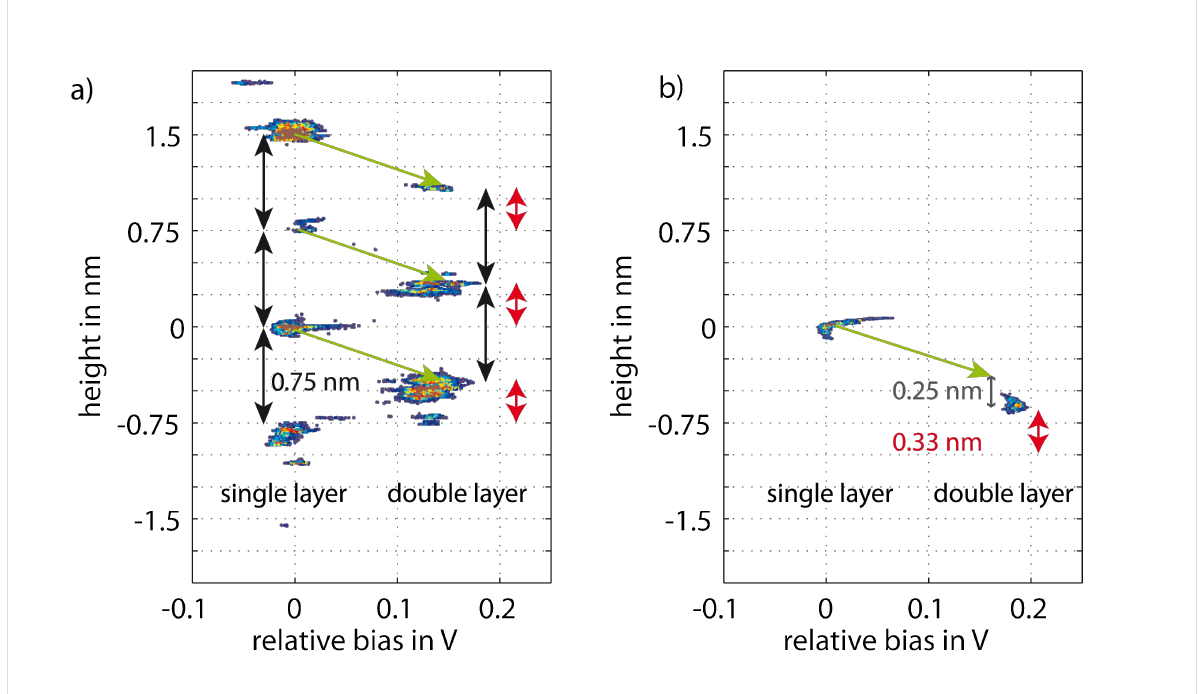
Figure 5: Two-dimensional histograms based on the data set for the rendered images in Figure 4. The colour scheme represents the number of data couples that fall into the respective topography and contact-potential bin; (a) sample prepared in UHV, (b) in an argon atmosphere. Black arrows indi- cate a height difference of 0.75 nm, equal to half a unit cell of 6H-SiC(0001), and the grey arrow a height of 0.25 nm, equal to one bilayer of SiC(0001). Red arrows indicate the step height of 0.33 nm corresponding to one graphene layer. Green arrows indicate a suggested graphene growth process, in which three SiC bilayers are consumed to produce one single graphene layer. Points with less than 5 counts are left transparent to enhance readability of the graph. The colour scale ranges from 5 (blue) to 70 (red) occurrences per 0.01 nm and 1.75